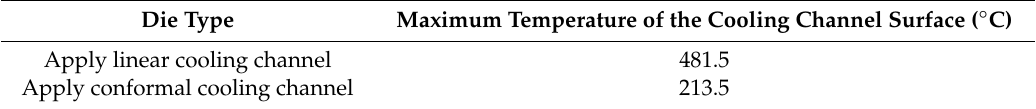
Figure 11. Temperature distribution of cooling water obtained through heat-flow analysis of continuous process; surface temperature distribution of ( a ) conformal cooling channel; ( b ) conventional linear cooling channel. Table 8. Comparison of the maximum temperature of the cooling channel surface of each die.